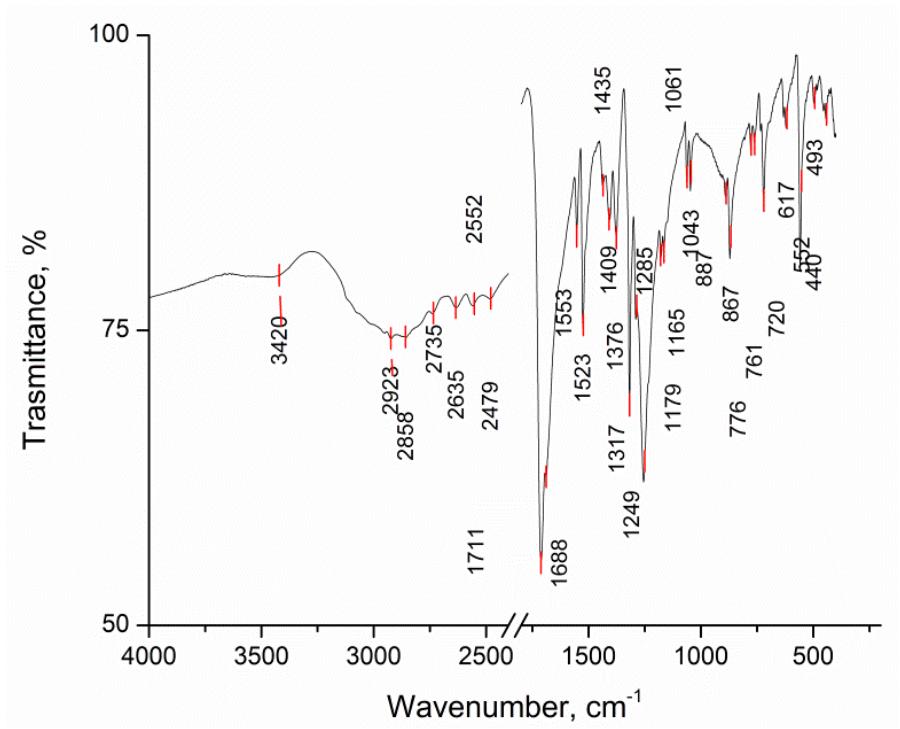
Figure 4. FT-IR spectrum of acid 1 .